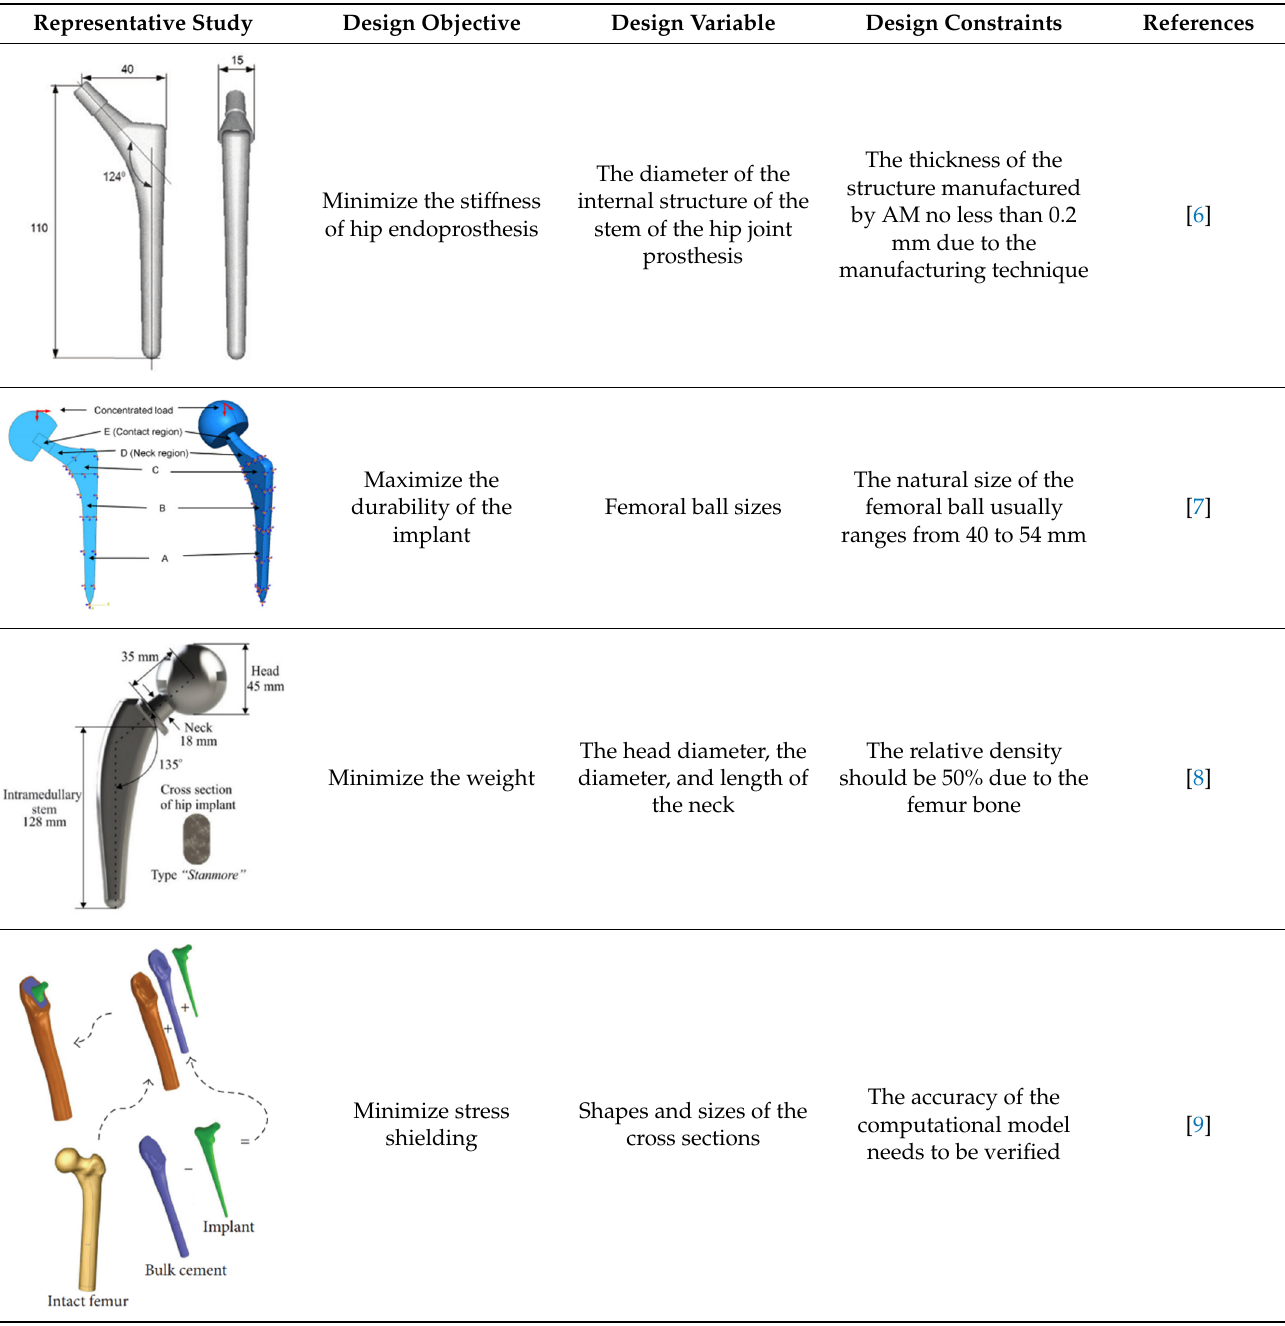
Table 1. The design of hip joint replacements.